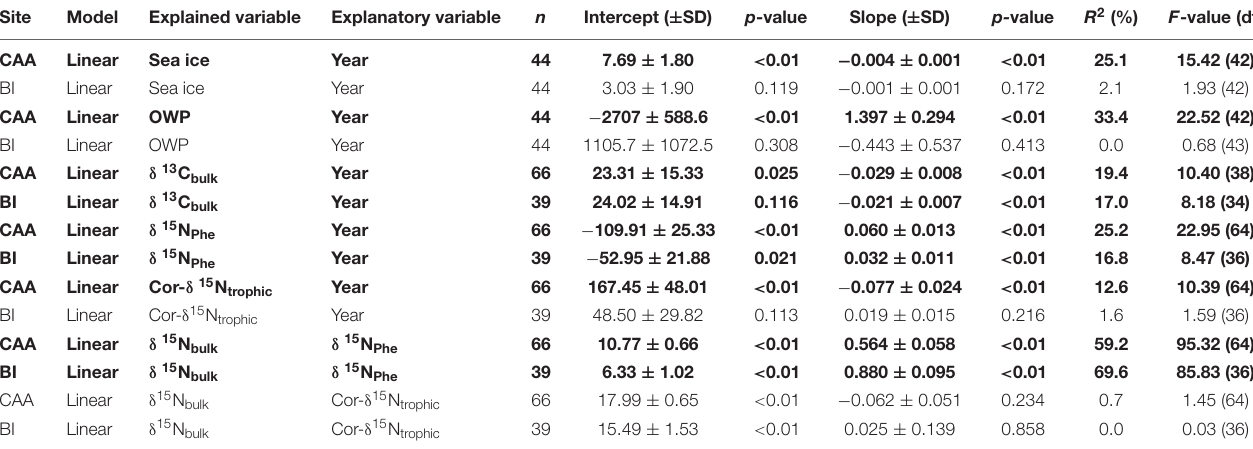
TABLE 2 | Statistical parameters of the linear models for stable isotopes of ringed seal muscle, sea ice concentration, and open water period from each Arctic regions. Site Model Explained